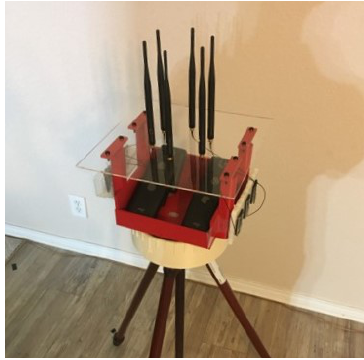
Figure 6. A custom designed 3D-printed panning measurement platform with 360 ◦ scale for horizon- tal rotation.